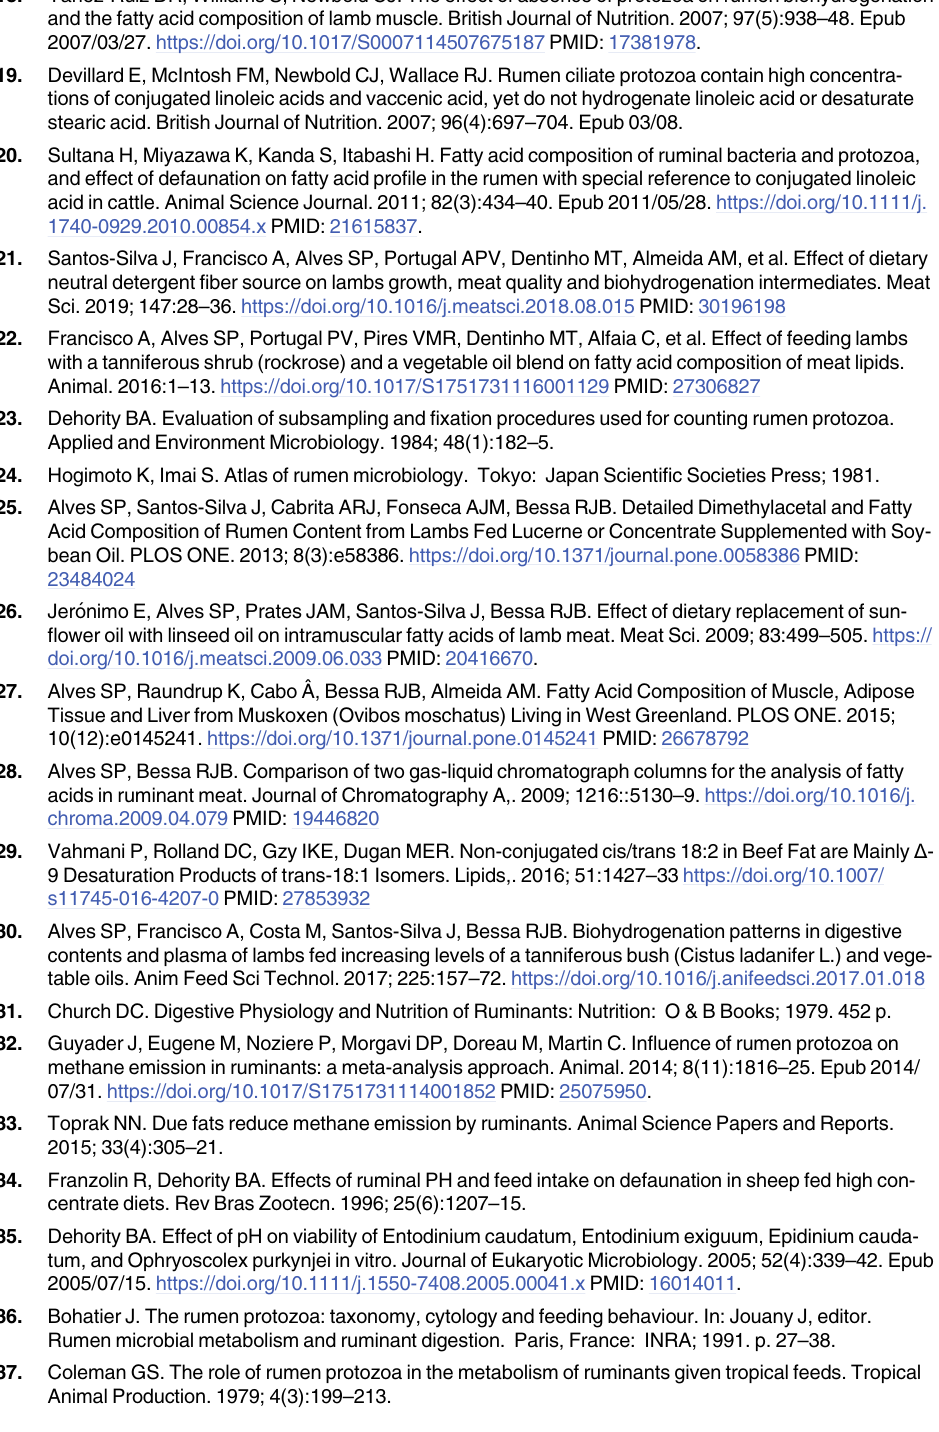
table oils. Anim Feed Sci Technol. 2017;